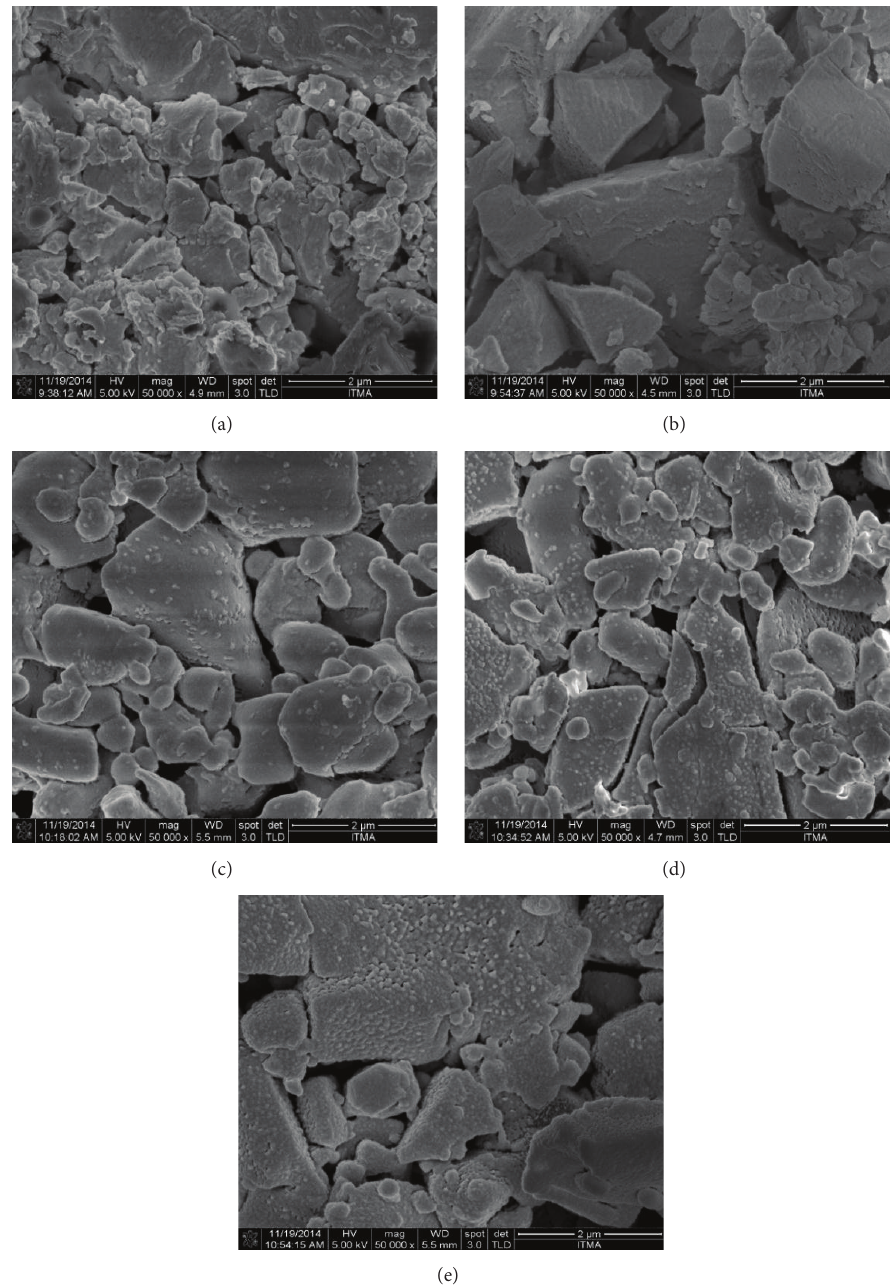
Figure 2: FESEM micrograph of undoped and Mn-doped Zn 2 SiO 4 based glass-ceramic sintered at 600 ∘ C: (a) undoped, (b) 1wt.% MnO, (c) 2 wt.% MnO, (d) 3 wt.% MnO, and (e) 10wt.%